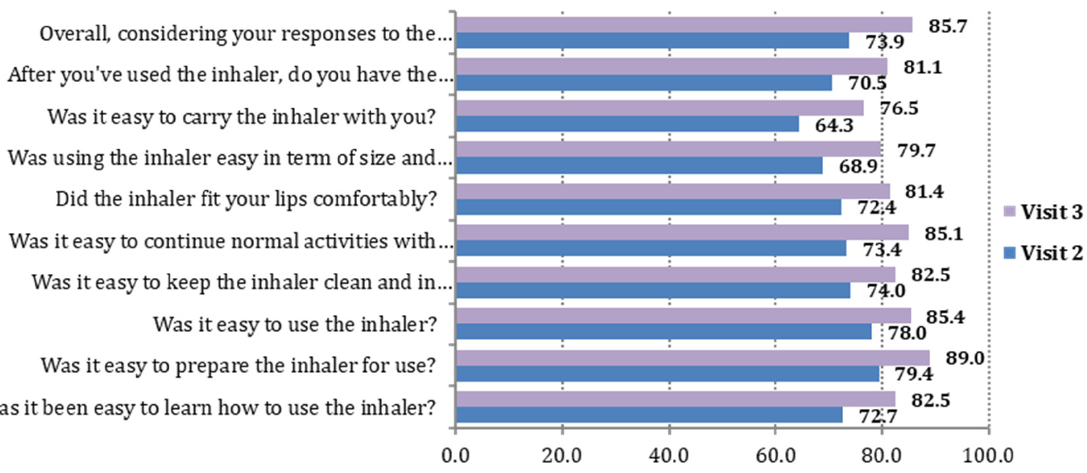
Figure 1. Visits 2 and 3. The 10 items of the FSI-10 Questionnaire: percentage (%) of patients who answered “very”.